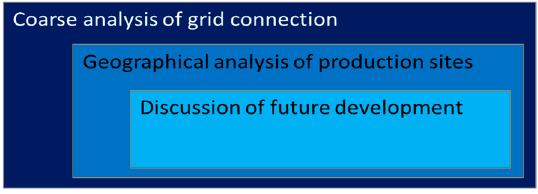
Figure 3. Overview of investigation.